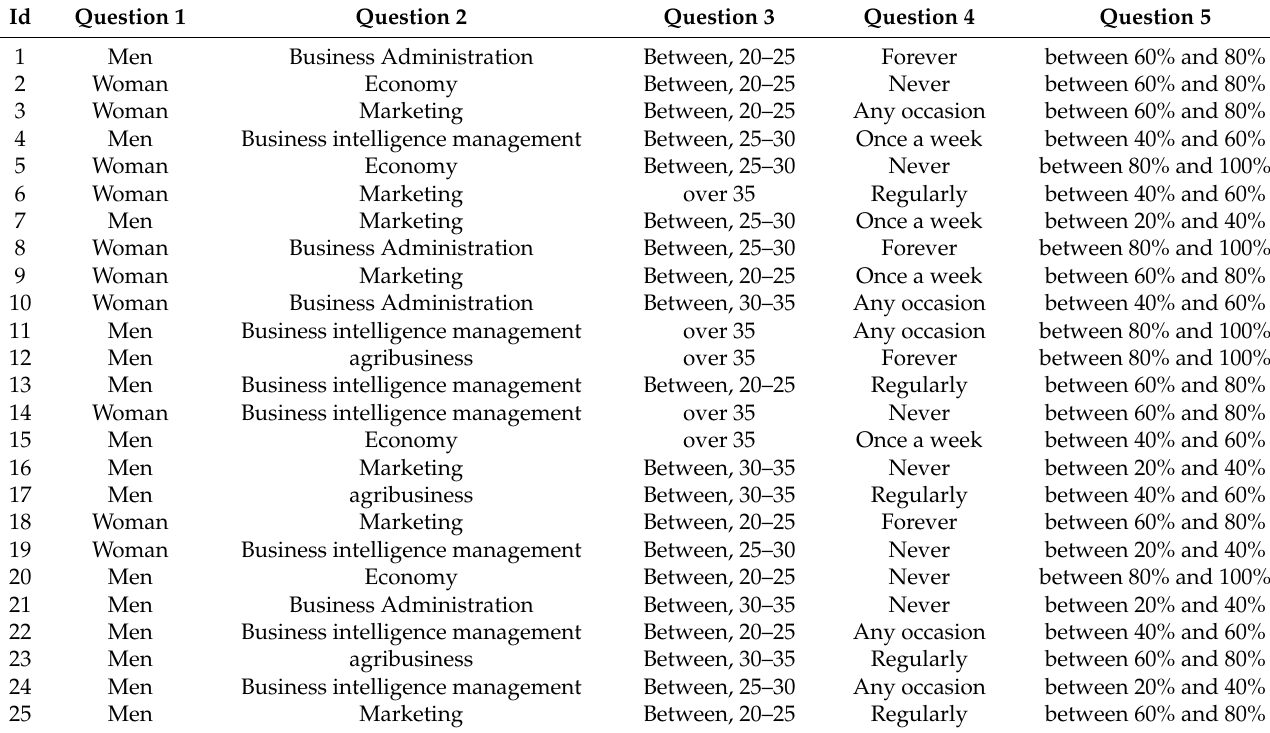
Table 5. Sample of the data obtained from the survey carried out on 2260 students, 6 columns of 14 are maintained to maintain the format of the